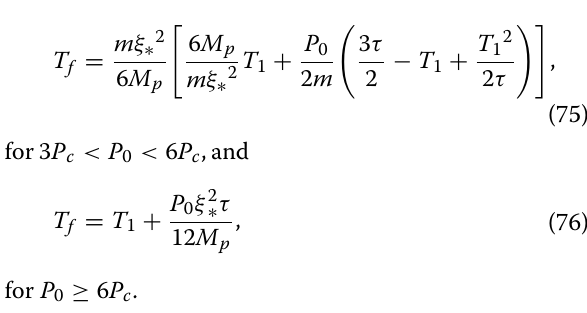
Fig. 16 indicates the bending moment evolution of the beam at phase transition for both the theoretical and the LCP models. The bending moment distribution is for the decaying pulse with initial amplitude P 0 = 12.5P c . Again, both the LCP solution and the theoretical solution show substantially close agreement from the start until the